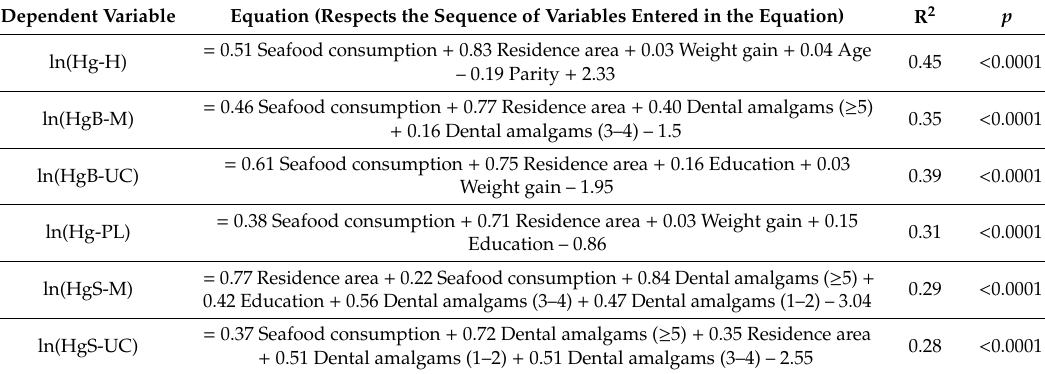
Table 5. Stepwise multiple linear regression results for relationship of Hg concentration in maternal hair ( n = 135), blood and serum, and umbilical cord blood and serum ( n = 205). Dependent Variable Equation (Respects the Sequence of Variables Entered in the Equation) R